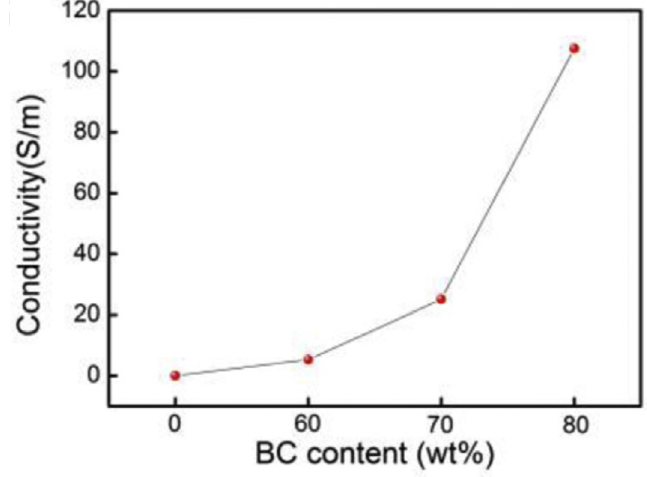
Figure 4. Electrical conductivity as a function of the content of commercial BC particles derived from Bamboo charcoal for UHMWPE/LLDPE composites [68]. Reproduced with permission from Elsevier Science Ltd. 2018, Elsevier Science Ltd.